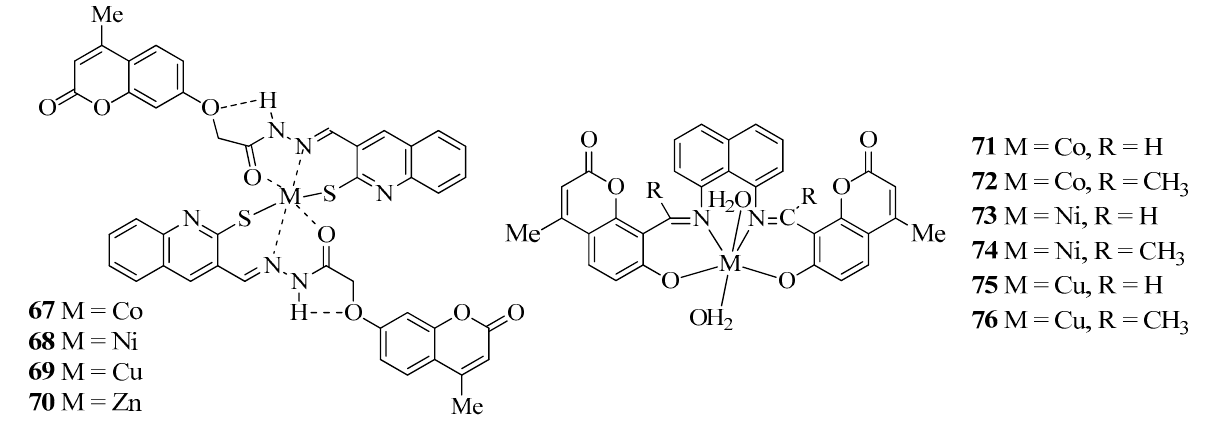
Figure 4. Structures of coumarin-derived imine–metal complexes ( 1 – 76 ). Table 1. Antimicrobial activity of coumarin-derived imine–metal complexes.